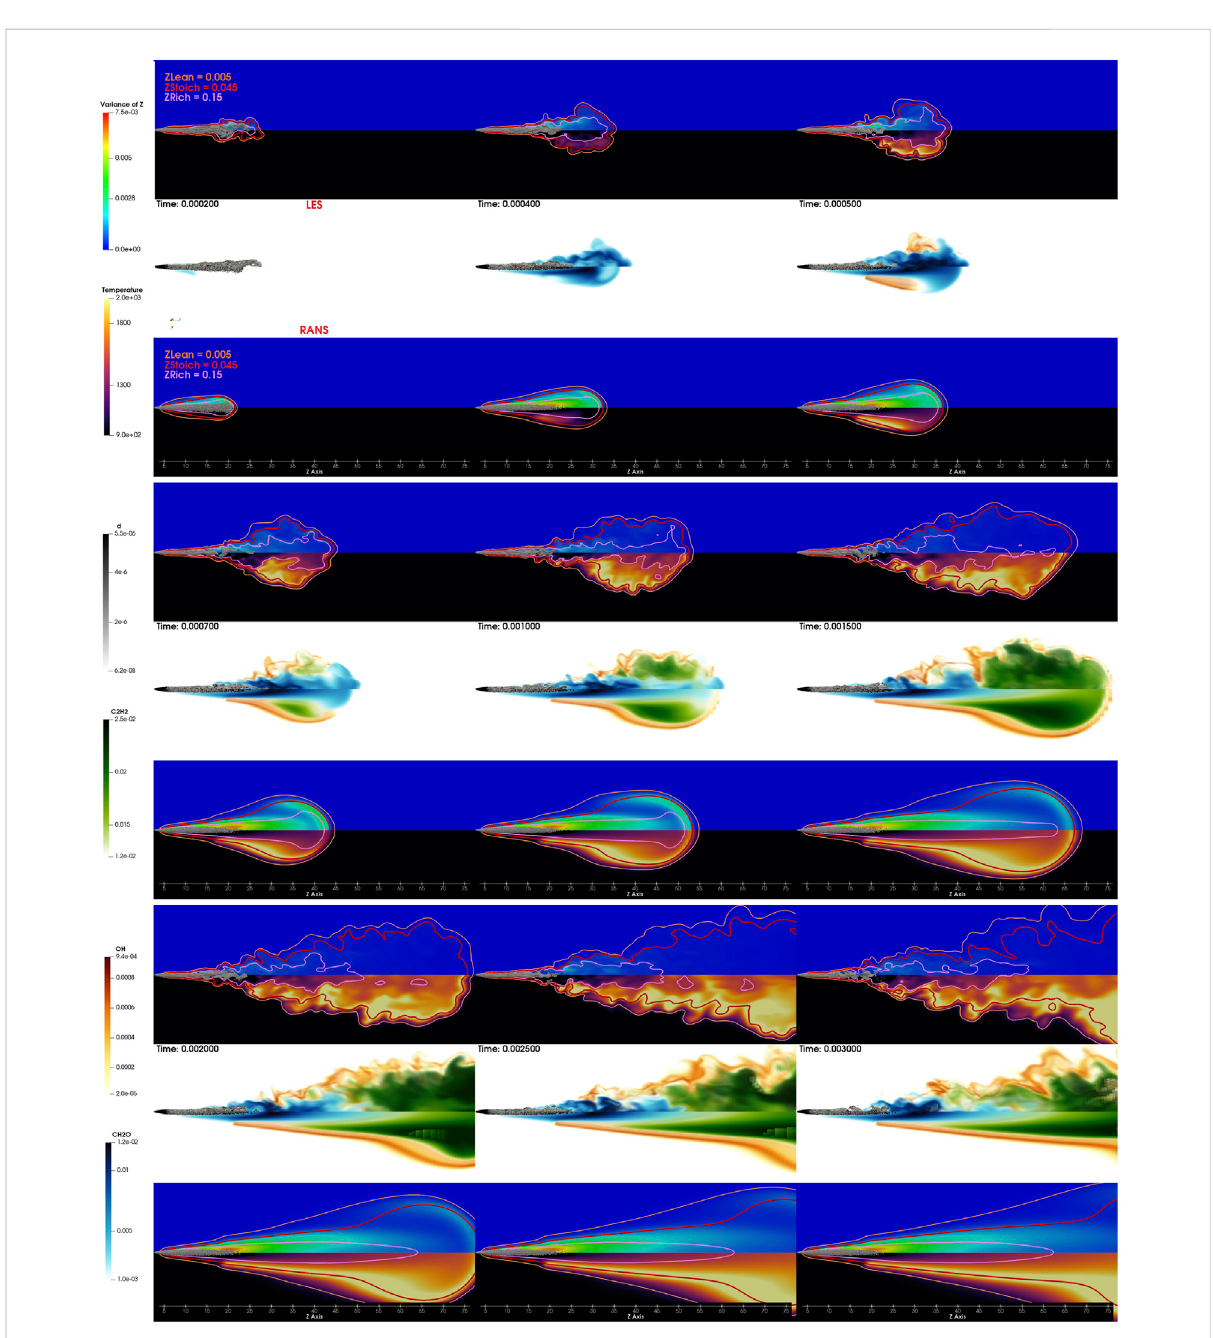
FIGURE 7 Spray C fl ame evolution from 0.2 ms to 3 ms. The image is divided into three parts: from 0.2 to 0.5 ms, from 0.7 to 1.5 ms, and from 2 to 3 ms. Each part is further divided into three: the central image represents OH, CH 2 O, and C 2 H 2 for the LES (upper) and RANS (lower) frameworks. The surrounding images are the temperature distribution, the variance of the mixture fraction, and three contours of the mixture fraction (lean, stoichiometric, and